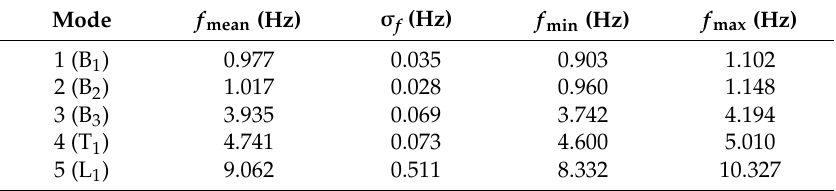
Table 1. Statistics of the natural frequencies identified (SSI-Cov) from 17/12/2012 to 17/03/2014.